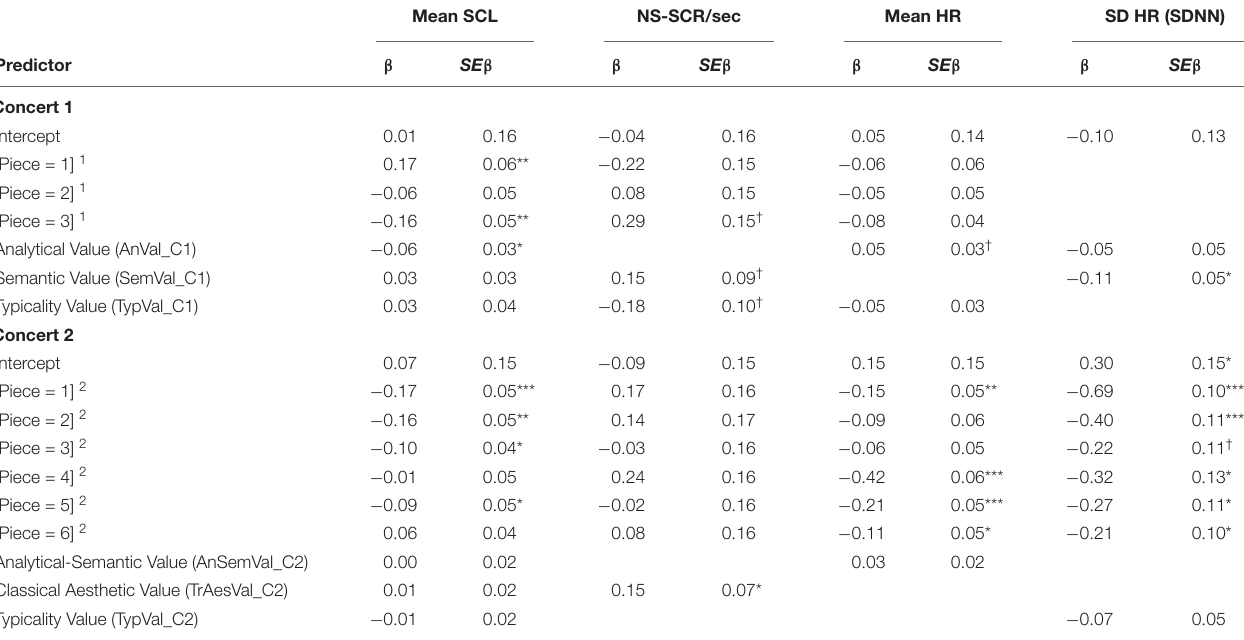
TABLE 9 | Hierarchical linear models of aesthetic judgment value factors and pieces of music as predictors of physiological response